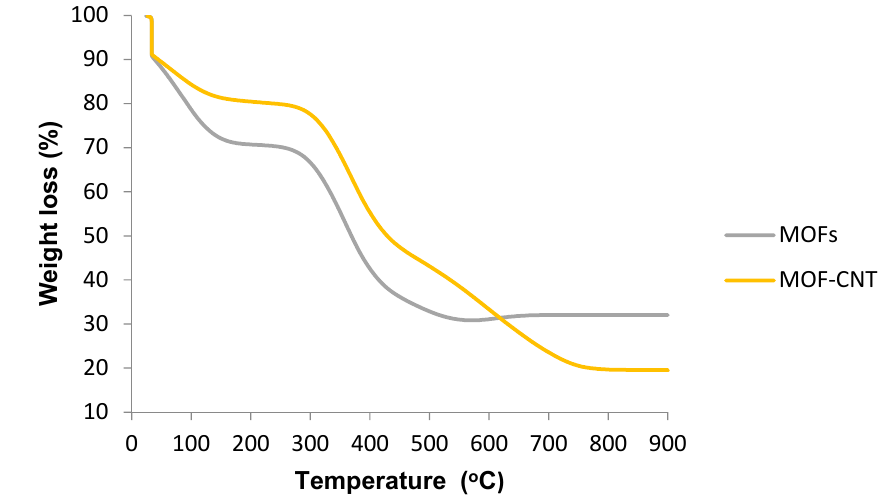
Figure 8. Thermogravimetric analysis (TGA) of HKUST-1 and FMWCNT/HKUST-1.